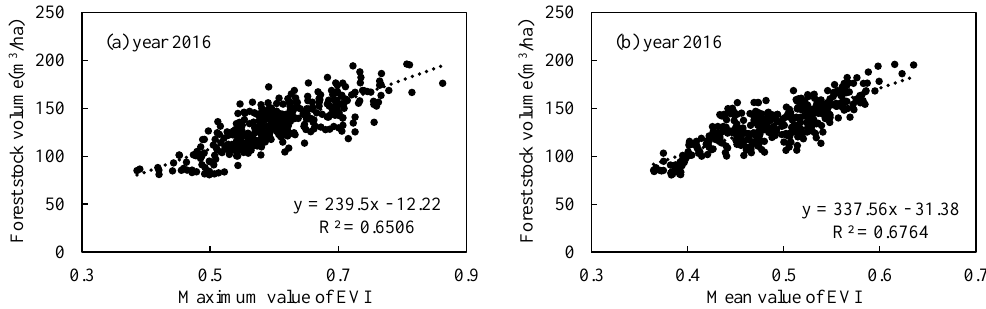
Figure 3. Spatial correlation analysis. ( a ) Spatial correlation between maximum value of EVI and forest stock volume in 2016; ( b ) spatial correlation between mean value of EVI and forest stock volume in 2016.